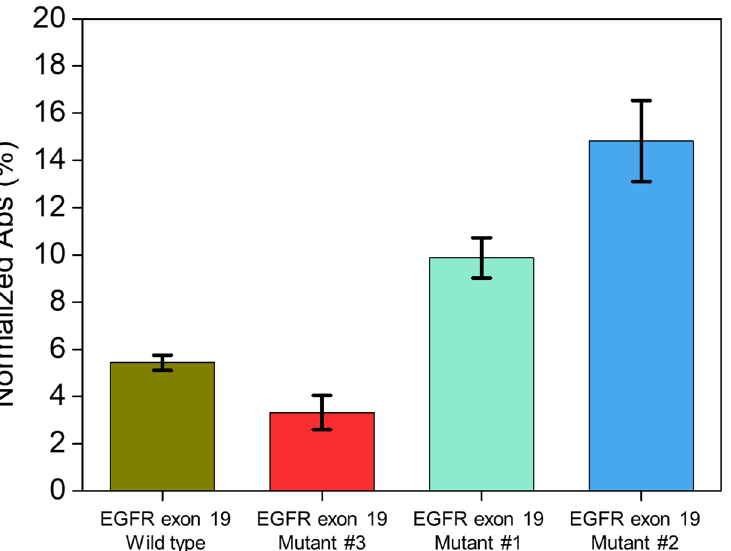
Figure 5. Selectivity experiment of EGFR exon 19 mutants and wild type DNA. The exact value is 5.4% ± 0.3%, 3.3% ± 0.7%, 9.8% ± 0.8%, and 14.8% ± 1.7% for wild-type, mutant #3, mutant #1 and mutant #2, respectively. The concentration of the DNA was 3.85 × 10 − 5 nM. Each bar data has been tested at least three times.